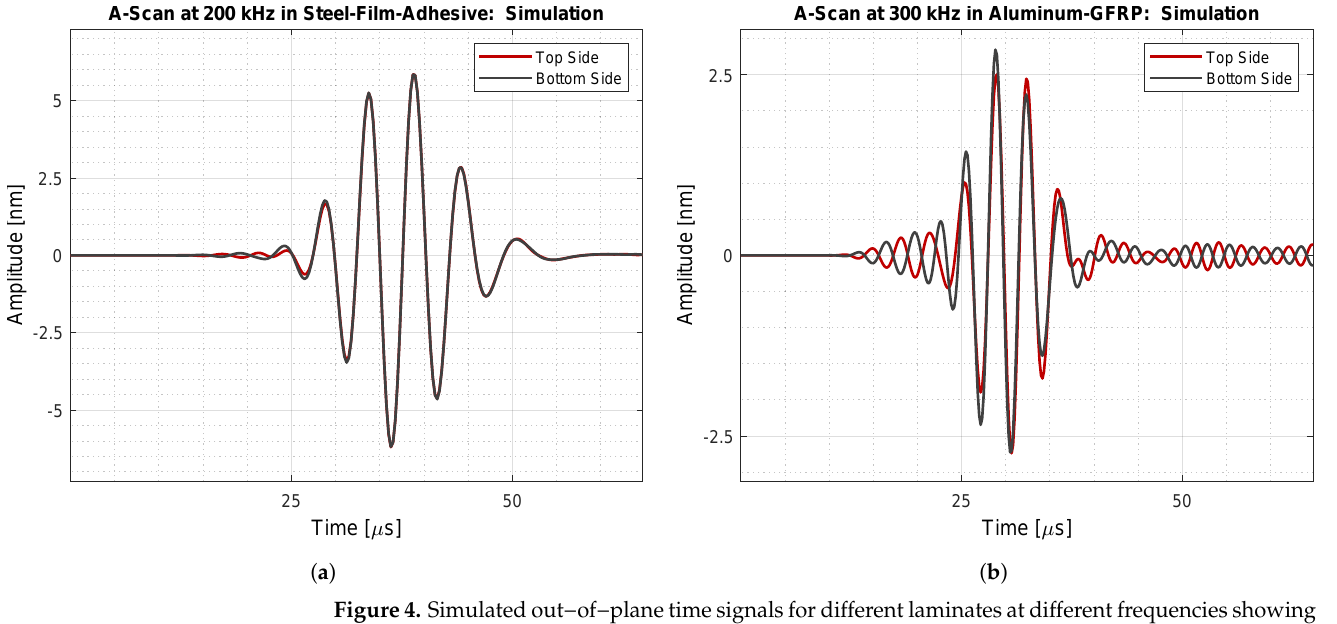
Figure 4. Simulated out−of−plane time signals for different laminates at different frequencies showing the division into areas of different oscillations. ( a ) Out−of−plane time signals of the wave propagation in the steel-film adhesive at 200kHz assigned to signal group 1. ( b ) Out−of−plane time signals of the wave propagation in aluminum-GFRP at 300kHz as example for signal group